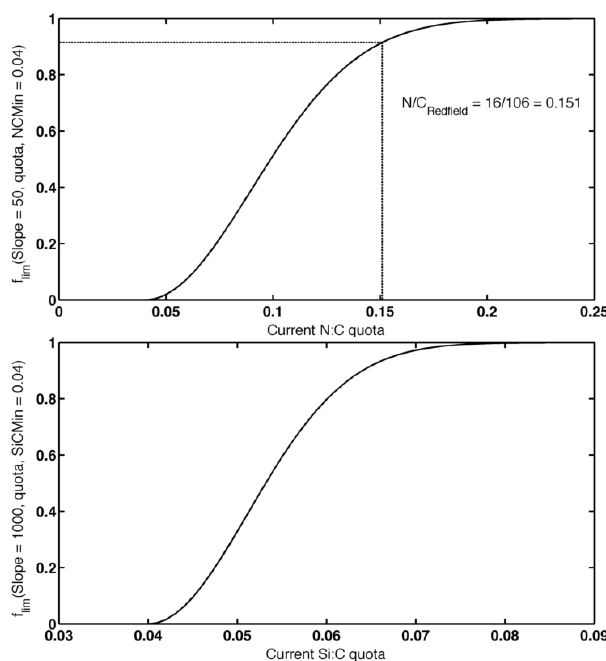
Figure A3. Change in the limiter function f N:Cmin quota.